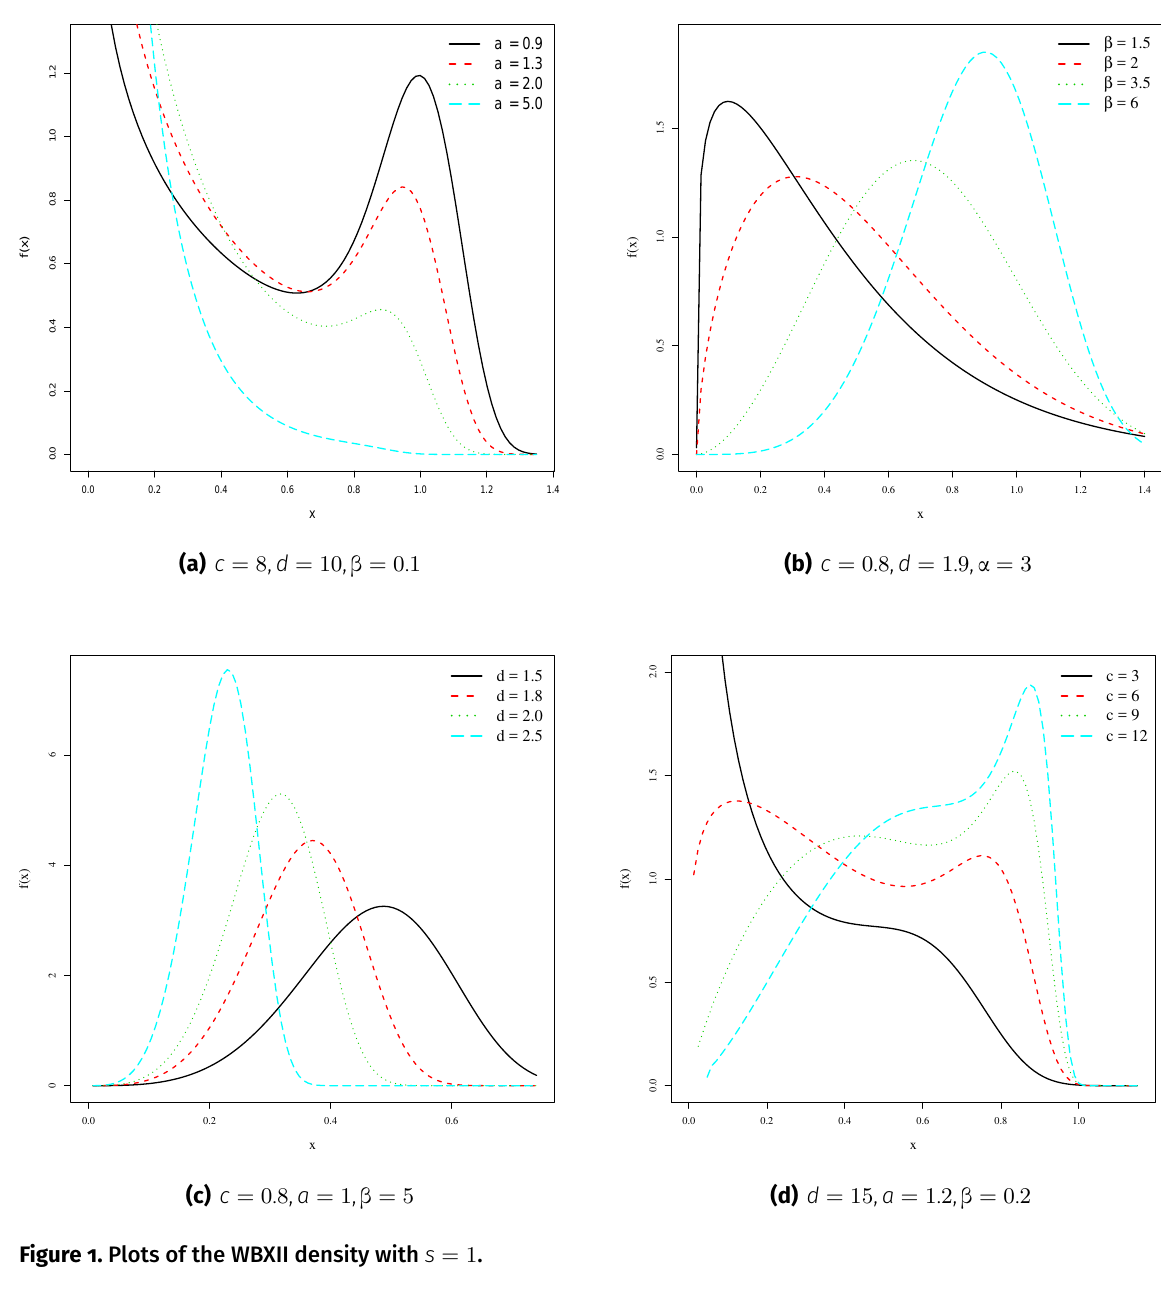
Figure 1. Plots of the WBXII density with s = 1